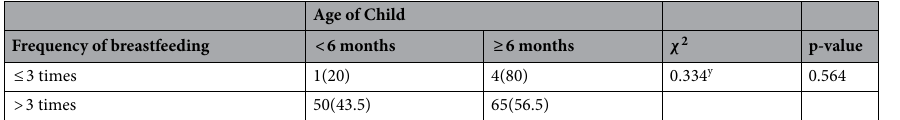
Table 5. Complementary feeding practices: frequency of breastfeeding child. χ